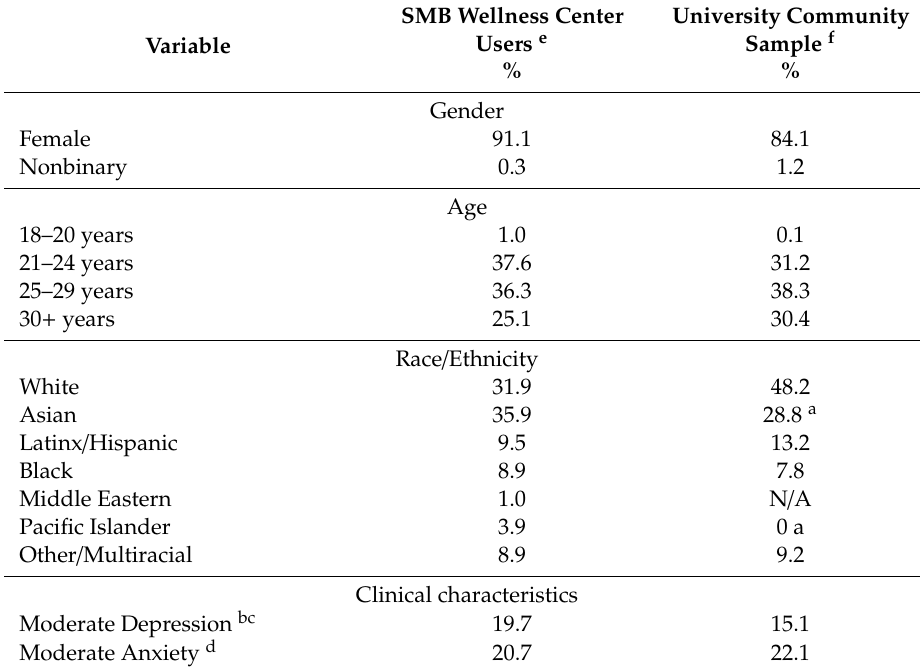
Table 3. Comparison of SMB Wellness Center Users to University